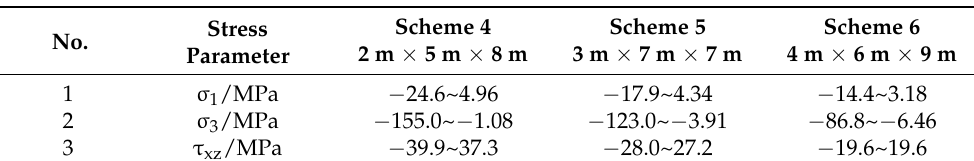
Figure 22. Minimum principal stress distribution in the middle of the pillar at 1480 mL of scheme 2 (parameters of scheme 2: stope height 2.5 m, pillar diameter 3 m, pillar spacing 6 m, pillar row spacing 8 m). Table 5. Numerical calculation with stope height of 3.5 m.